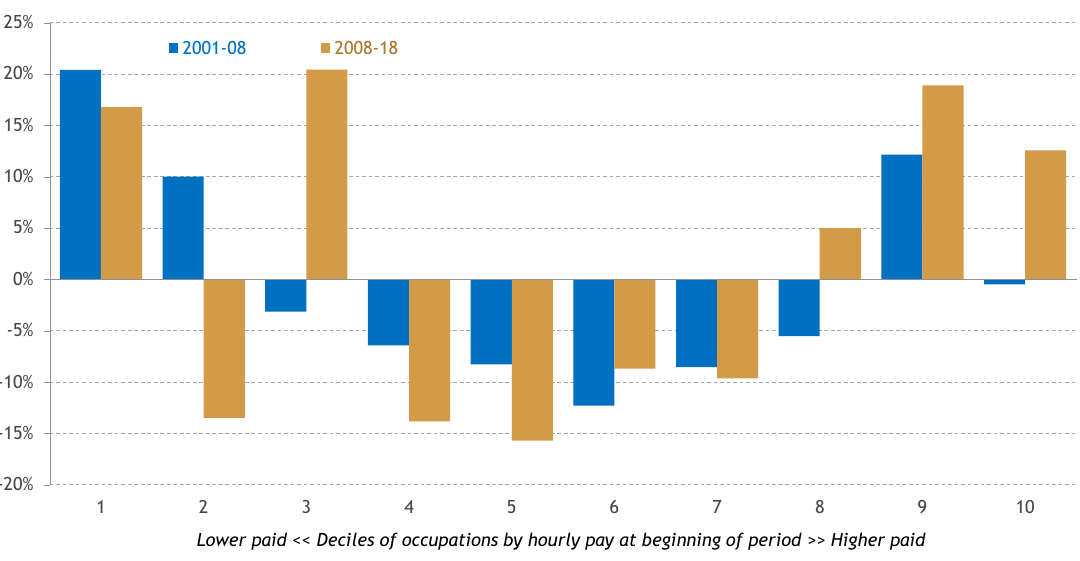
Figure 24: The financial crisis exacerbated it but polarisation began before it Percentage change in hours share, 18-29 year